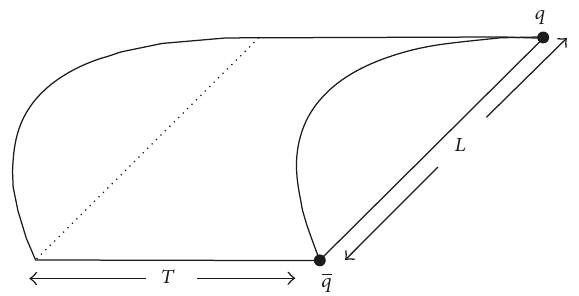
Figure 2: Curved worldsheet surface of the static stringcorrespond- ing to a time interval 𝑇 . The associated Wilson loop is the plane rectangle of sides 𝑇 and 𝐿